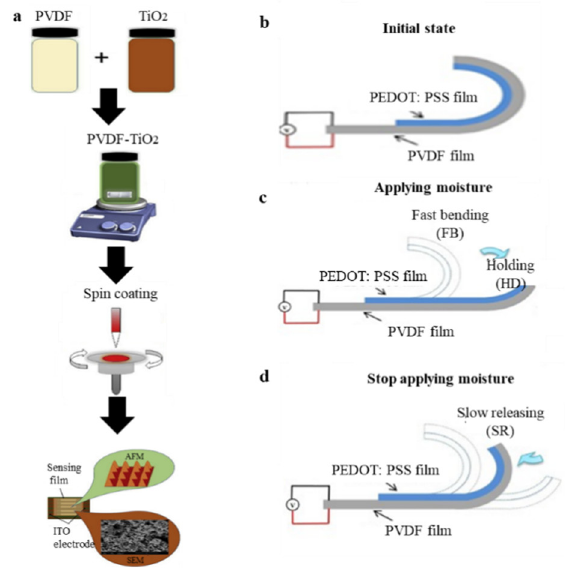
Figure 12. ( a ) Schematic of the spin coated PVDF-TiO 2 on interdigital ITO electrode [159]; and ( b – d ) graphical representation of the PEDOT:PSS/PVDF generator producing a stable DC voltage [160]. graphical representation of the PEDOT:PSS / PVDF generator producing a stable DC voltage